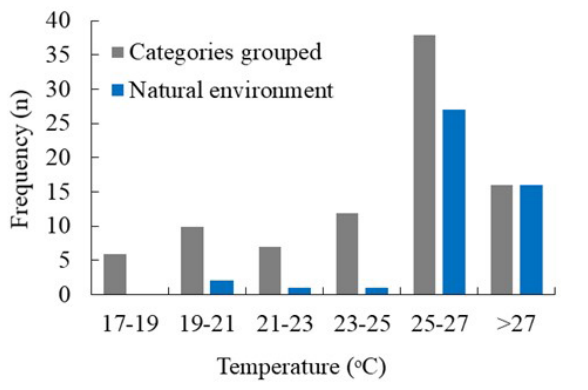
Figure 2. Frequency of Macrobrachium rosenbergii occurrences in Brazil by temperature